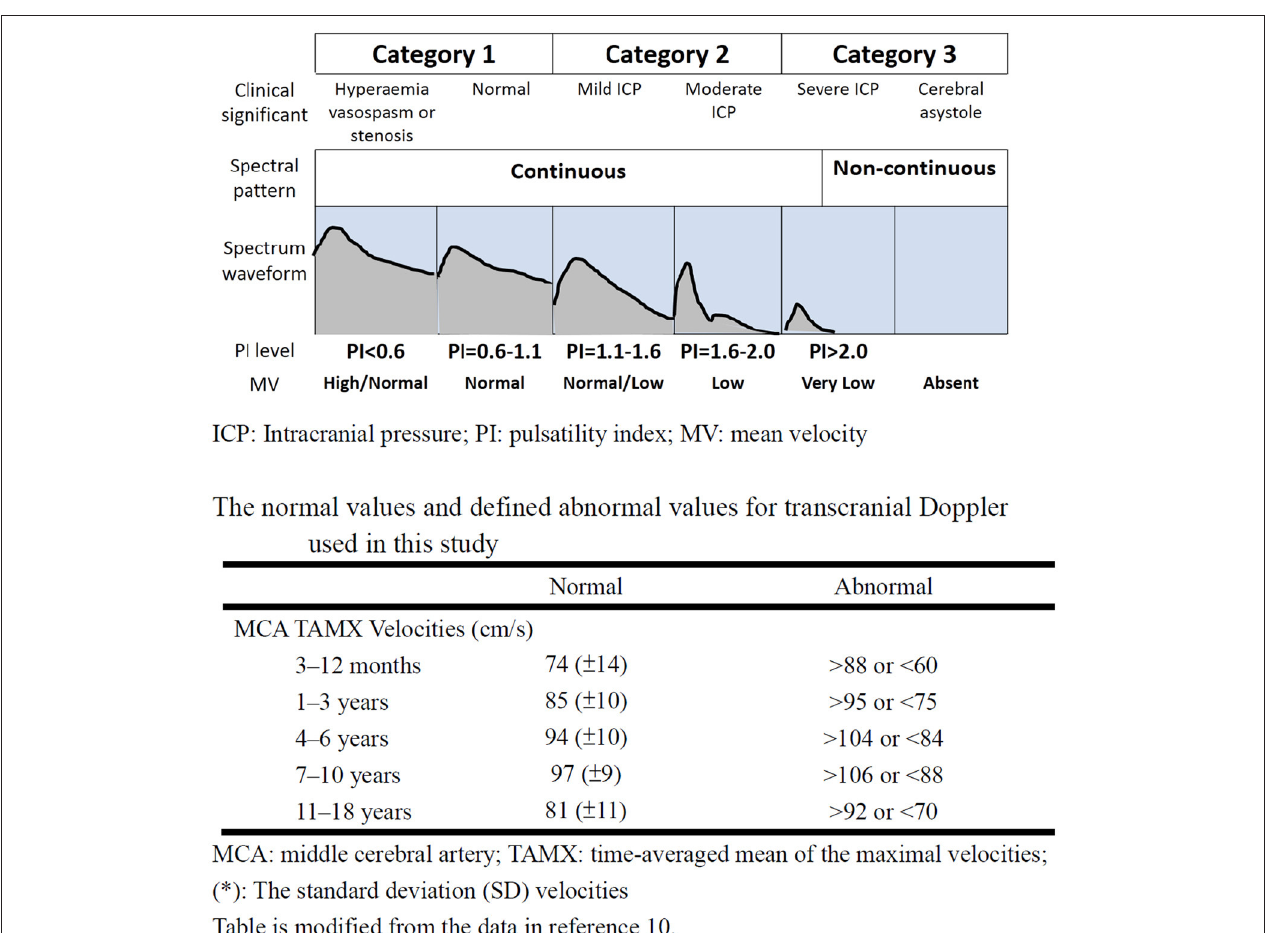
FIGURE 2 | The category of transcranial Doppler ultrasound findings according to spectral pattern, PI and mean flow velocities after the ROSC. The figure was modified from references 9 and 11. ICP, Intracranial pressure; PI, pulsatility index; MV, mean velocity; ROSC, return of spontaneous